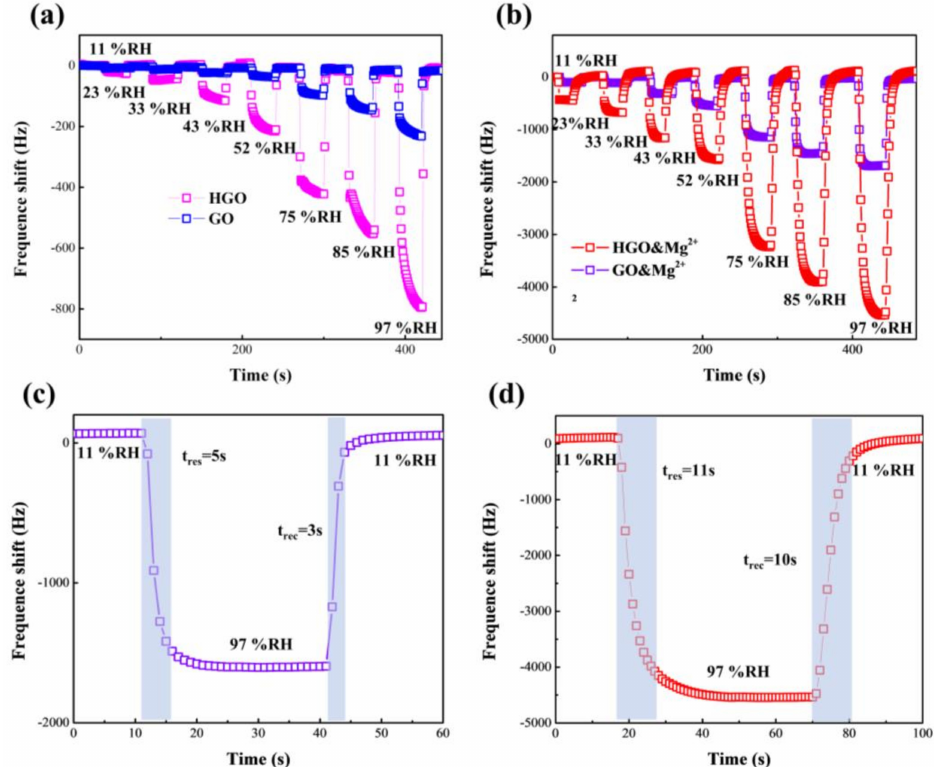
Figure 6. ( a ) Response-frequency shift of HGO- and GO-based QCM humidity sensors with relative- humidity (RH) of 11% to 97%. ( b ) Response-frequency shift of HGO&Mg 2+ - and GO&Mg 2+ -based QCM humidity sensors with RH of 11% to 97%. ( c , d ) Response and recovery times of HGO&Mg 2+